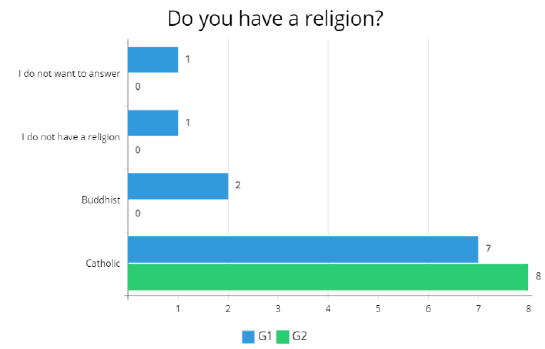
Figure 4. Investigation about religion of G1 and G2.